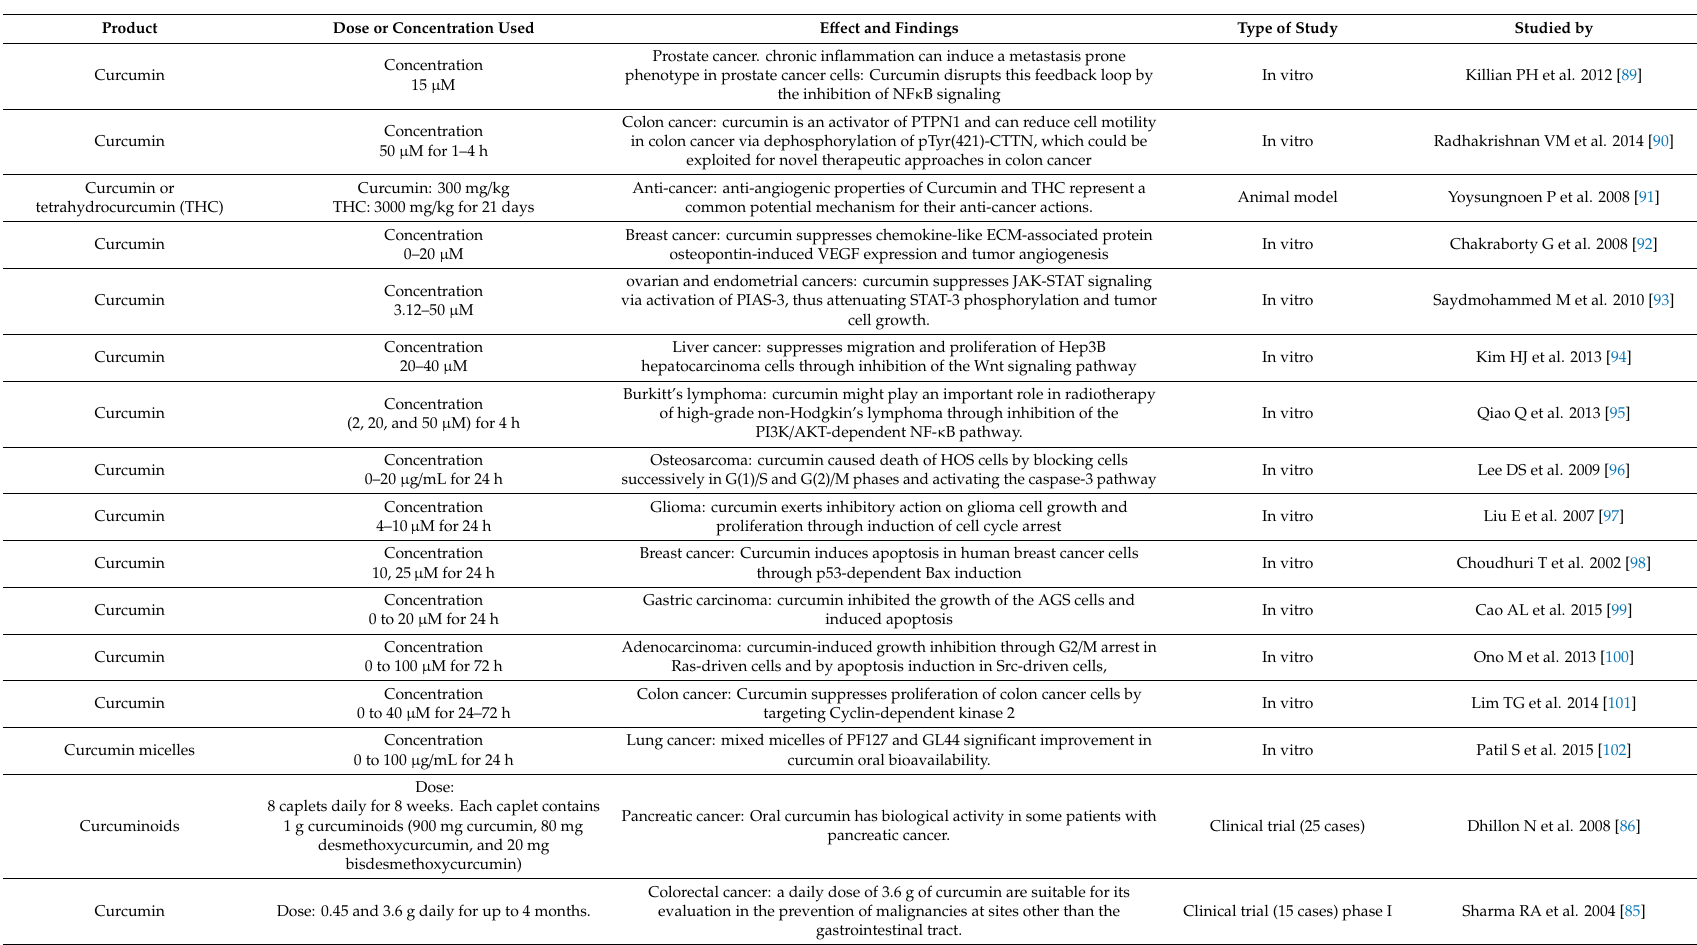
Table 4. Anti-cancer E ff ect of